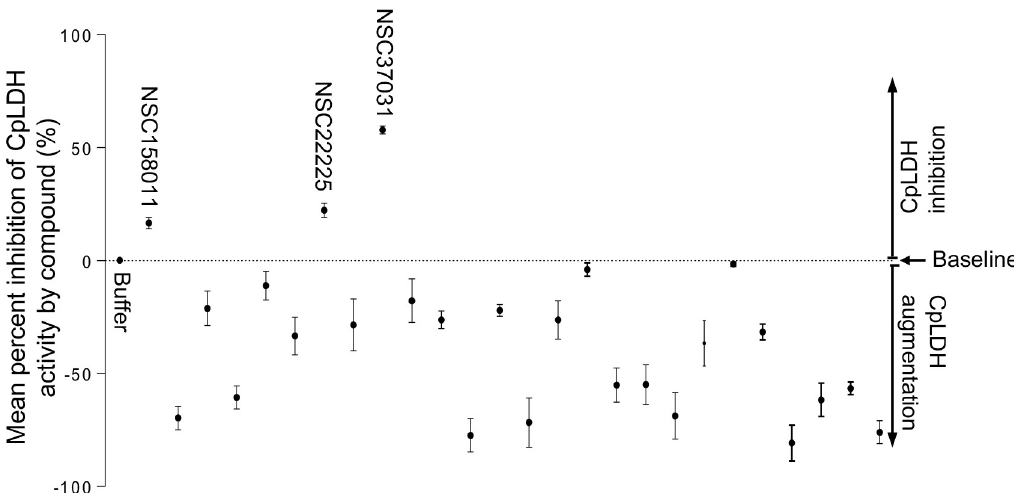
Fig 2. Effect of the diverse set compounds on the catalytic activity of recombinant CpLDH protein. Individually reconstituted compounds were used at a final concentration of 20 μ M in the reaction for the reduction of pyruvate to lactate with recombinant CpLDH protein as enzyme. The mean percent inhibition of CpLDH activity by each compound was derived by dividing the mean change in optical density ( Δ OD 340 ) of the reaction after 2 min in the presence of the compound by the mean Δ OD 340 of the reaction without compound, and multiplying the product by 100. The baseline mean percent inhibition of 0 (buffer) was for the reaction without compound, but with an equivalent volume of solvent used to reconstitute compound. Compounds with mean percent inhibition values greater than 0 were designated as inhibitors of the activity of CpLDH, while those with mean percent inhibition values less than 0 were classified as augmenters. Each reaction was performed in triplicate, and the data shown represents means of three independent